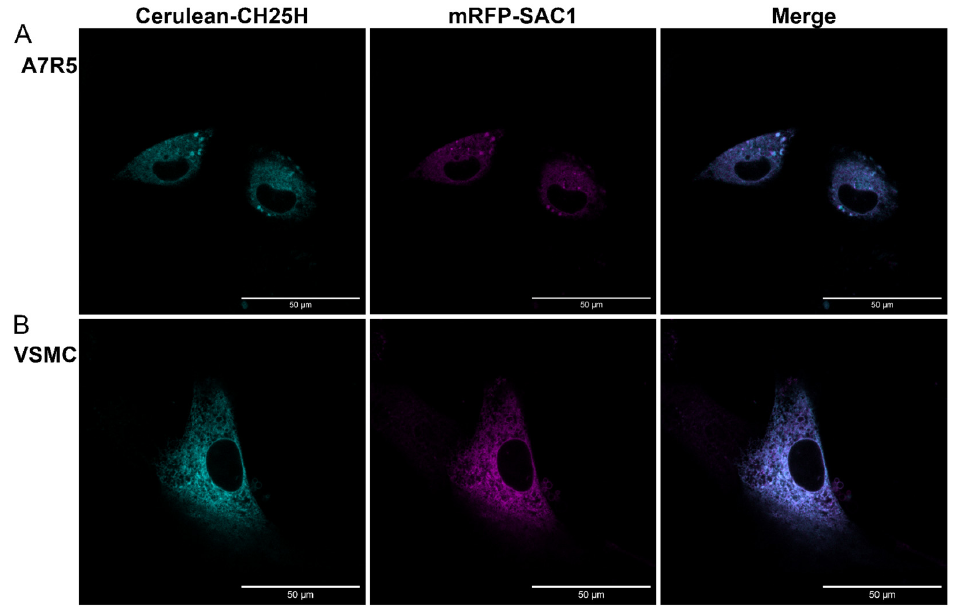
Figure 5. CH25H localizes to the endoplasmic reticulum in the A7R5 rat VSMC cell line and =primary rat VSMCs. ( A ) A7R5 cells and ( B ) primary rat VSMCs were cotransfected with DNA constructs encoding Cerulean-CH25H (cyan) and mRFP-SAC1 (magenta) fusion proteins. Twenty-four hours post-transfection, cells were examined using a Zeiss LSM710 confocal laser-scanning microscope. Merged images and colocalization analysis of signals show good colocalization of SAC1 endoplasmic reticulum marker and CH25H. Pearson’s correlation coefficient in A7R5 cells: 0.83 ± 0.038 = mean ± SEM, and in rat VSMCs: 0.85 ± 0.01 = mean ± SEM, n = 5 independent experiments. Fiji software was used for image processing and colocalization analysis. Scale bars represent 50 μ m.